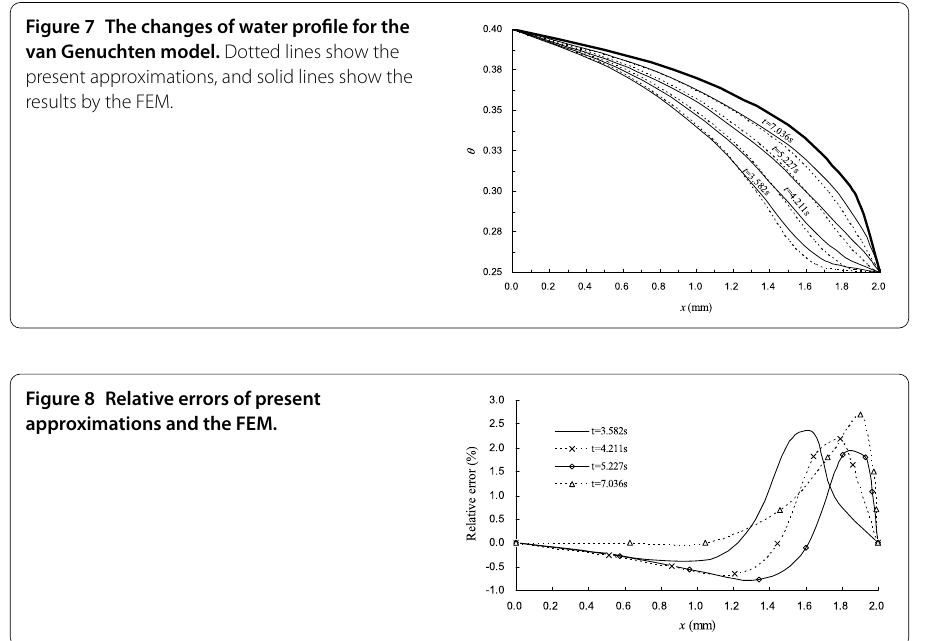
present approximations, and solid lines show the results by the FEM.